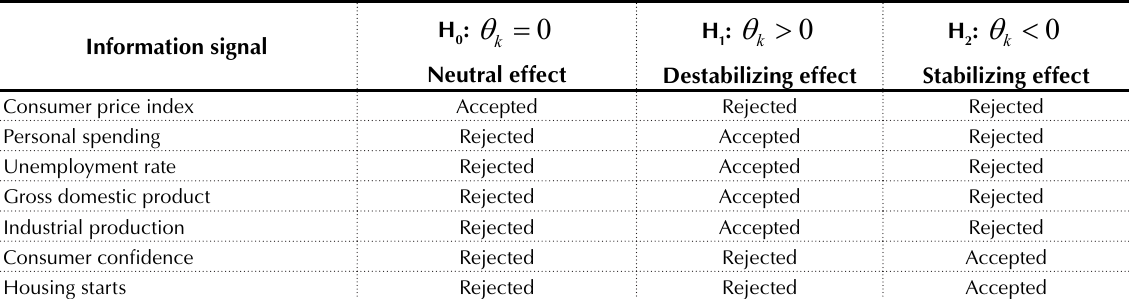
Table 8. The results of testing the hypotheses H component of the “surprise” of non-monetary information signals on stock quotes of enterprises of the economic sector “Utilities”